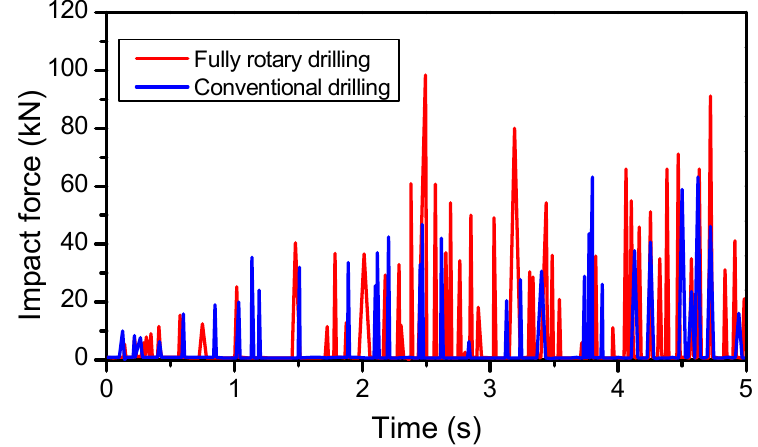
Figure 3. Impact force versus time between stabilizer and wellbore for both fully rotary and conventional drilling.